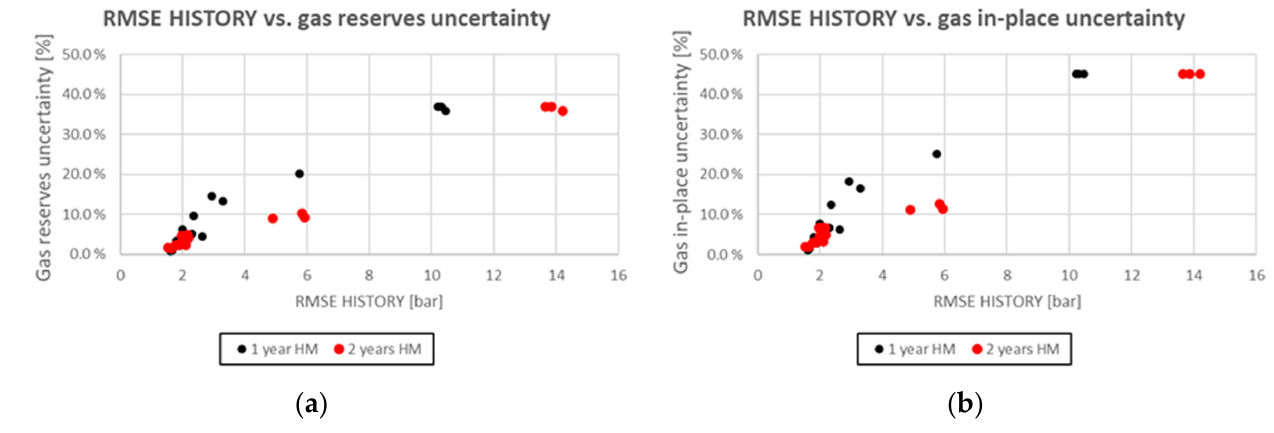
Figure 7. The impact of history match quality to the modelling uncertainty. ( a ) Gas reserves, ( b ) in- place volumes.